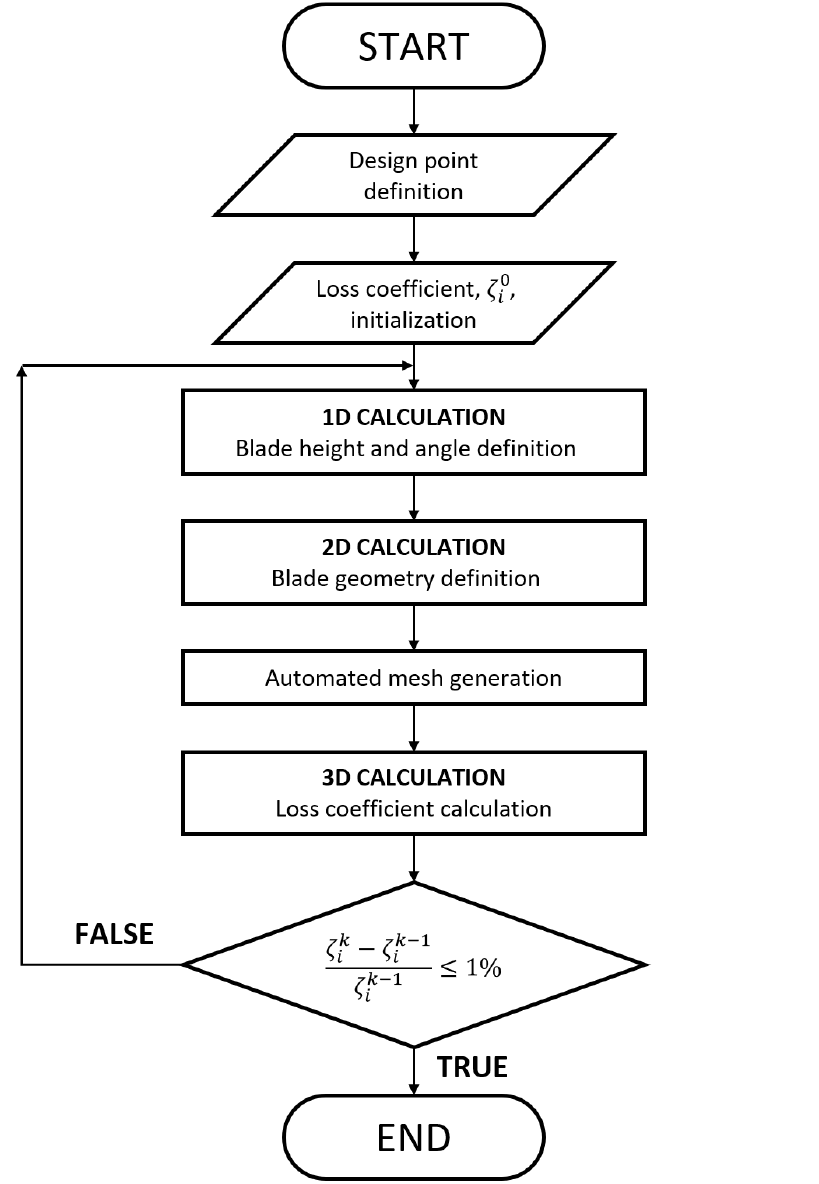
Figure 2. Flow chart of the proposed